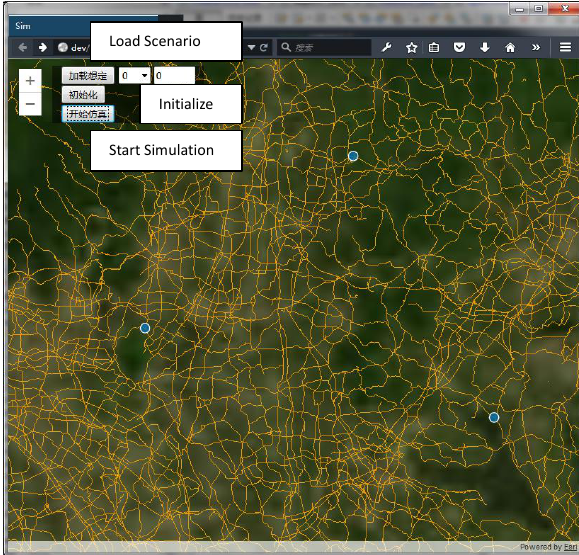
Figure 5. Screenshot of the Driving